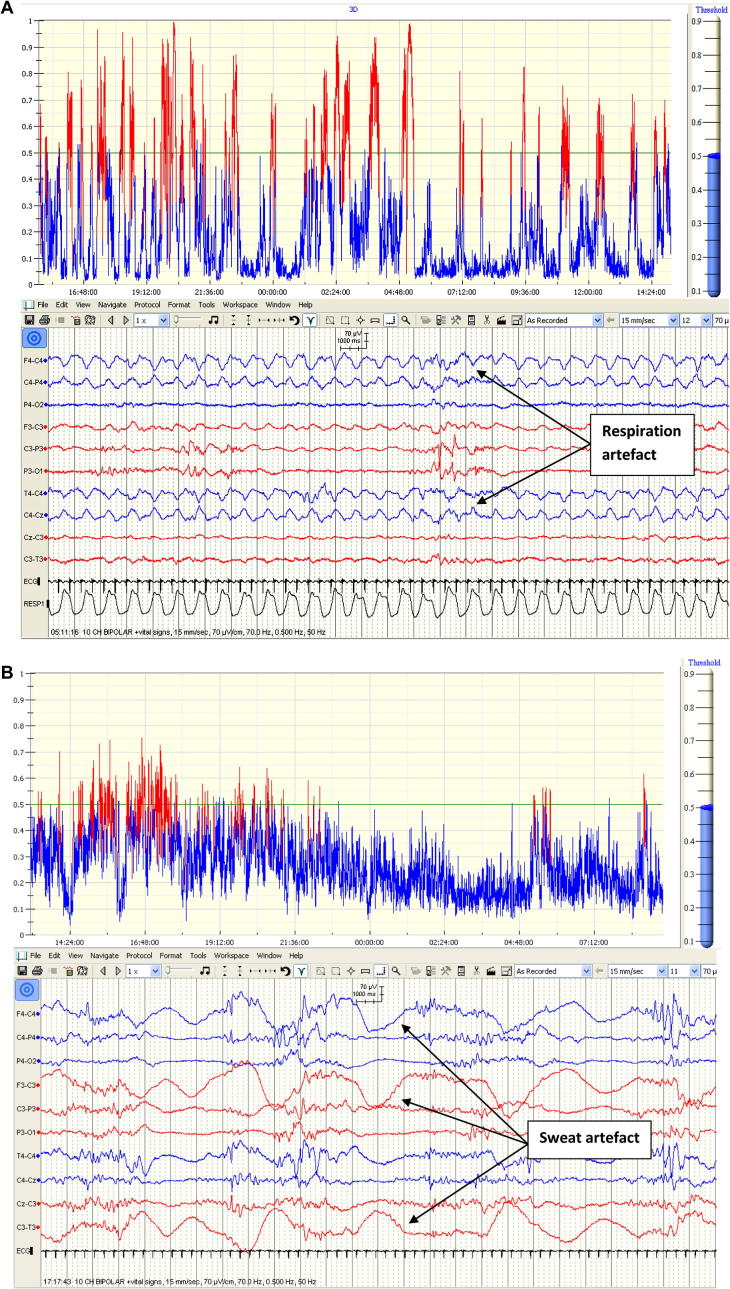
Effects of respiration and sweat artefacts on seizure probability output. (A) Highly rhythmic respiration artefact (lower panel) produces high probability peaks on SDA output graph (upper panel). (B) Intermittent semi-rhythmic slow sweat artefact on EEG (lower panel) produces a lower seizure probability output on graph (upper panel).